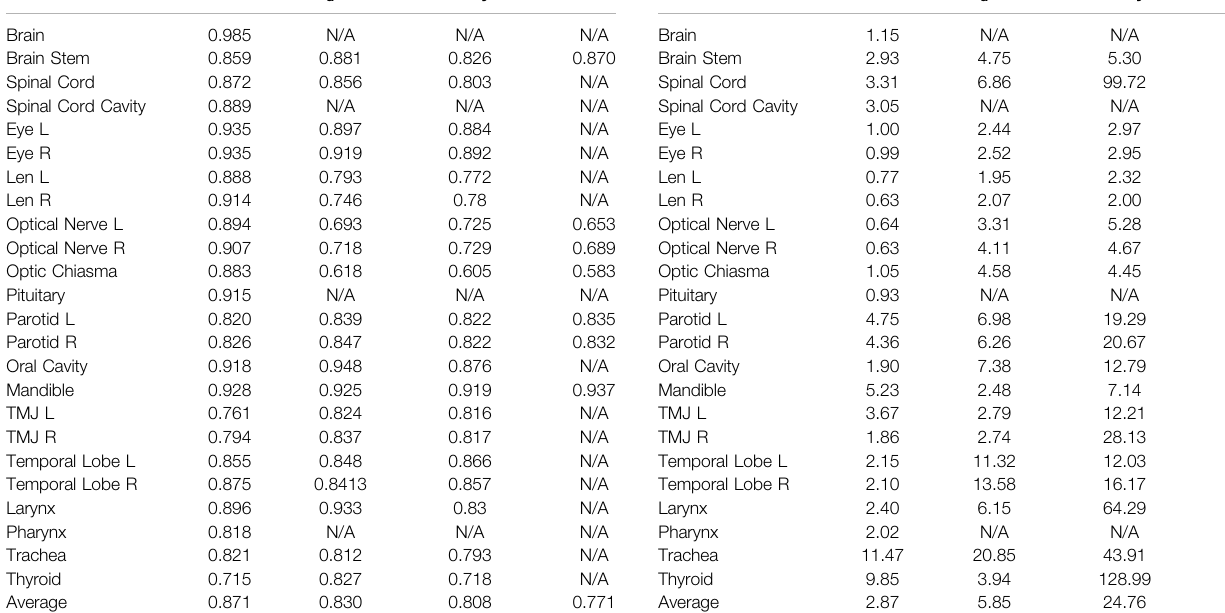
TABLE 2 | Average DSC comparison on the test. OARs SEB-net